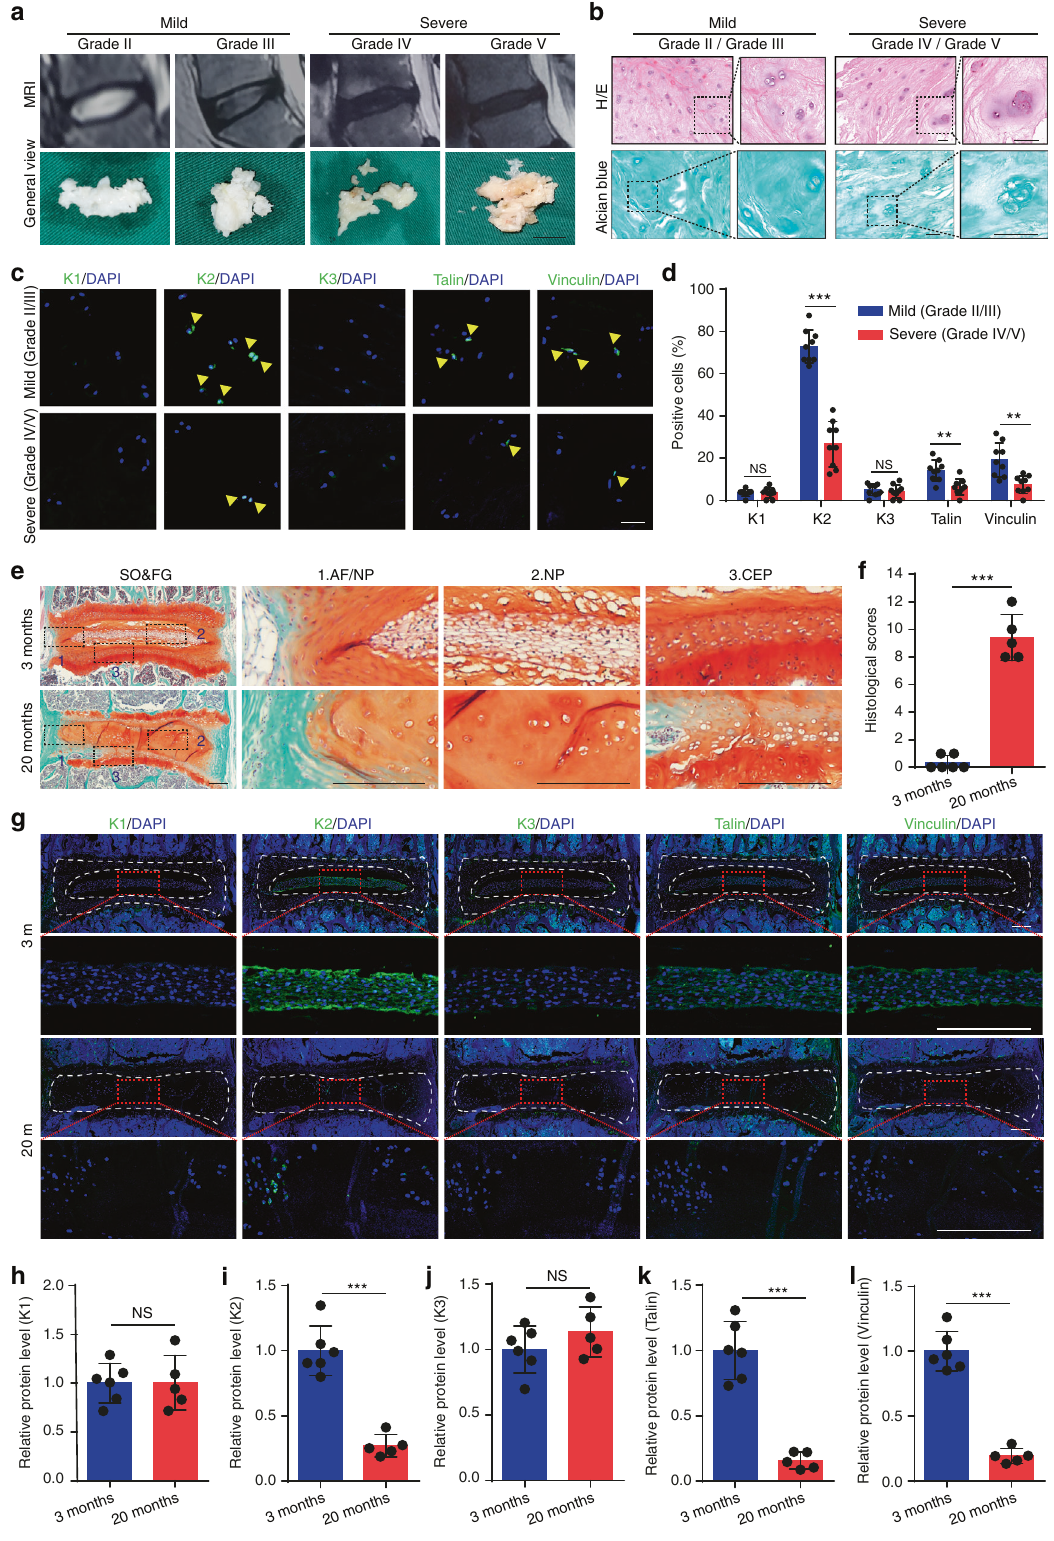
Fig. 1 The expression of Kindlin, Talin, and Vinculin proteins in degenerative human nucleus pulposus (NP) specimens and mouse intervertebral discs (IVDs). a Representative MRI images and general views of NP tissues with different P fi rrmann degrees. Scale bar, 1cm. b Hematoxylin and eosin (H/E) and Alcian blue staining of human NP samples. Scale bar, 50 μ m. c , d Immuno fl uorescent (IF) staining of KINDLIN-1, 2, 3 (K1, 2, 3), TALIN, and VINCULIN in human NP samples. Scale bar, 50 μ m. n = 9. e , f Safranin O and Fast Green (SO&FG) staining and histological scores of lumbar IVDs in young mice (3-month-old) and aged mice (20-month-old). Scale bar, 200 μ m. n = 6 (young) and 5 (aged). g – l IF staining of K1, K2, K3, Talin, and Vinculin in young and aged mice. Scale bar, 200 μ m. n = 6 (young) and 5 (aged). NS, no statistical signi fi cance, ** P <0.01, *** P